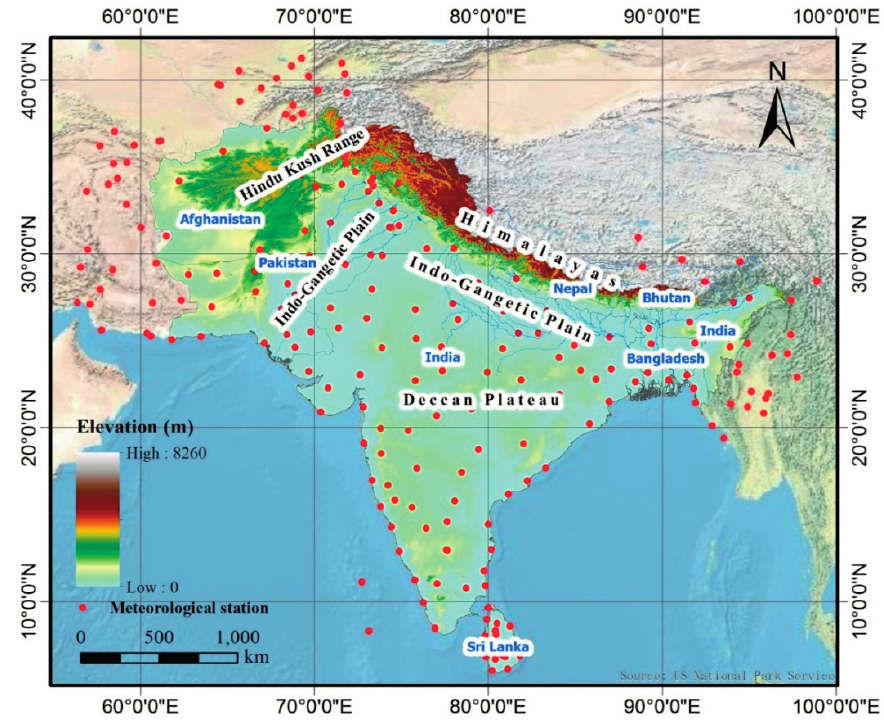
Figure 1. Core countries and the locations of available meteorological stations around South